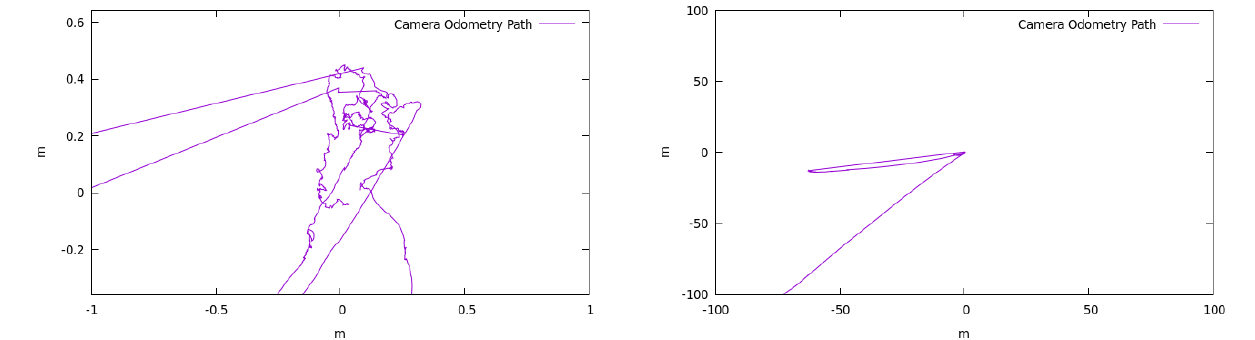
Figure 10. Tracking path for free movement with non-calibrated camera.